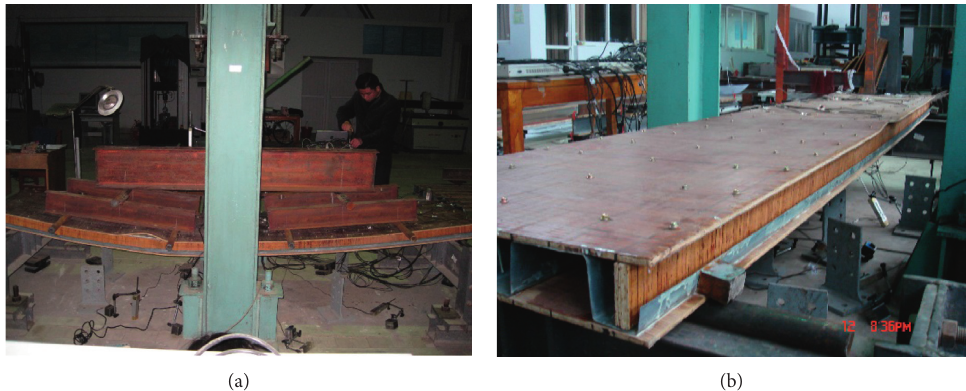
Figure 12: Deformation changes of RCBS. (a) Large deformation failure. (b) Recoverable